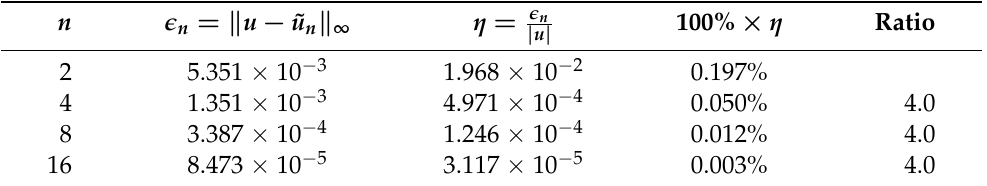
Table 8. IE (48), λ A = 50. QM: Trapezoidal rule and Polynomials.